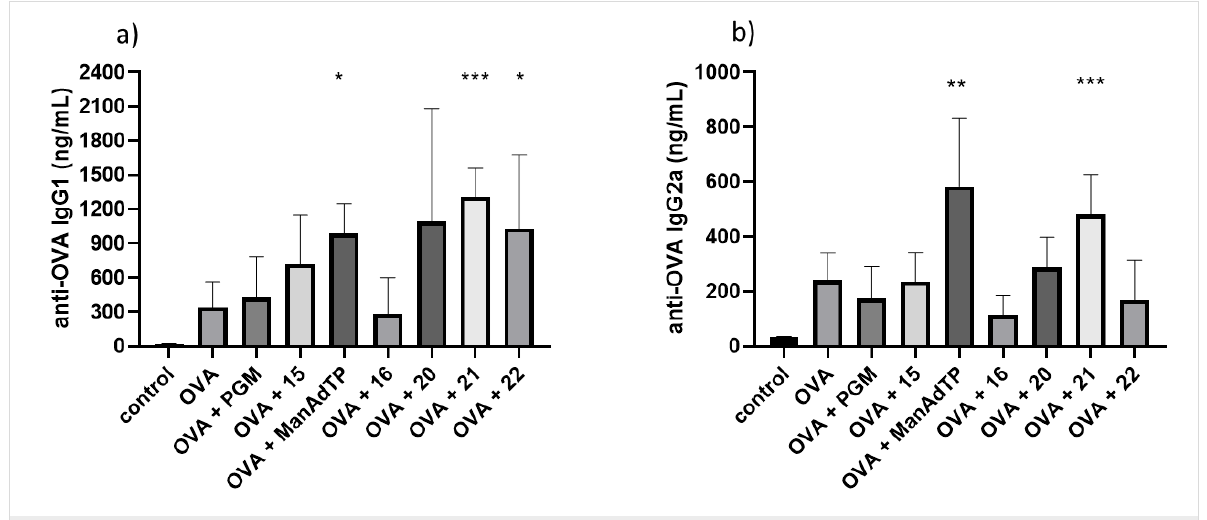
Figure 5: The effect of mannosylated desmuramyl peptides on production of anti-OVA IgG subtypes, anti-OVA IgG1 (a) and anti-OVA IgG2a (b), re- spectively, in BALB/c mice immunized with OVA as an antigen. Bar graphs represent average values from individual mice from each group ( n = 5). * p < 0.05 and *** p < 0.001 denote statistical significance in comparison to the control